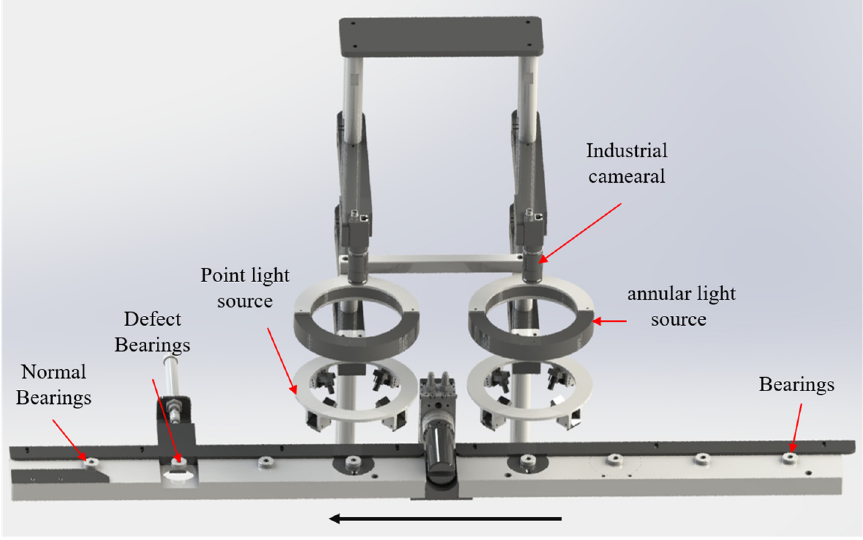
Figure 7. Bearing data collection platform.